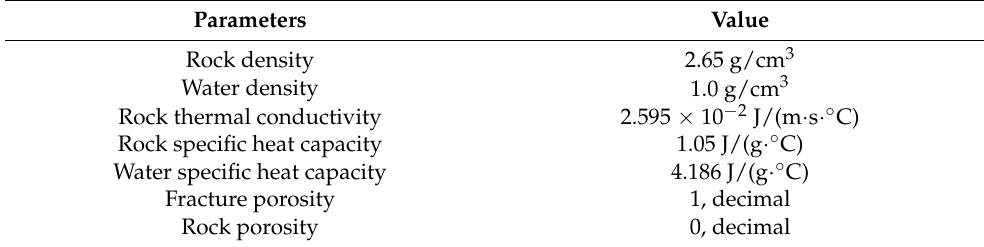
Table 1. The properties of rock and water used in the model